Question: Provide a one-line summary of what is displayed.
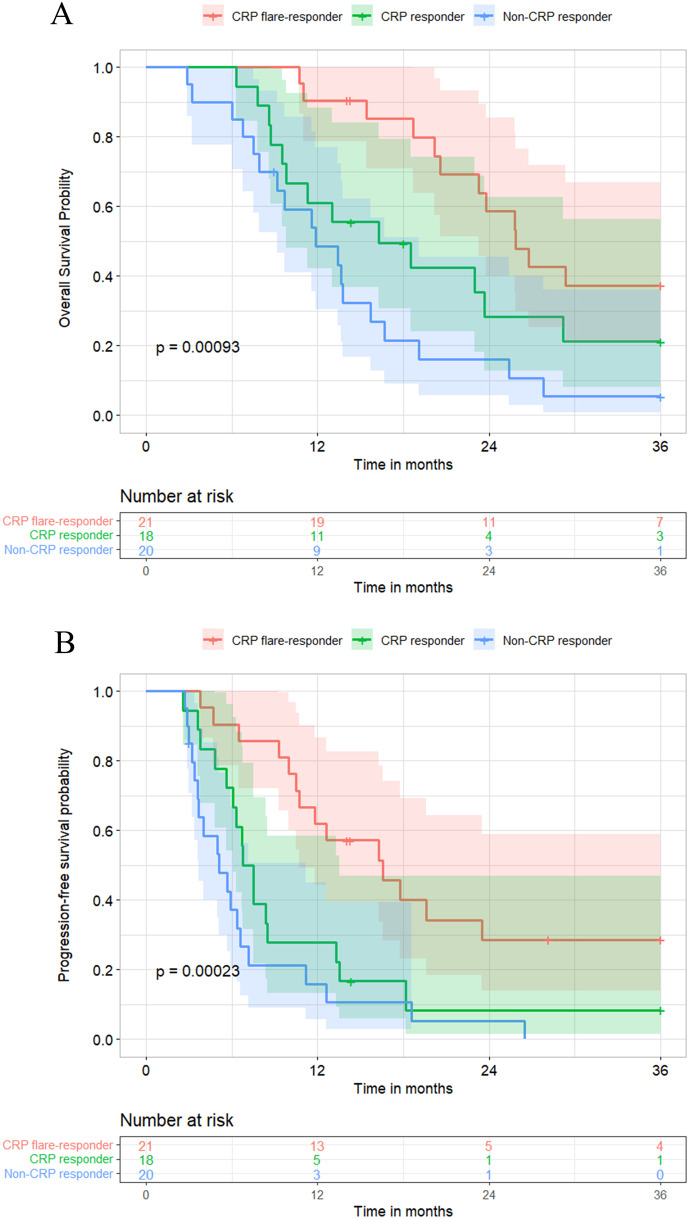
Answer: (A) overall survival curves and (B) progression-free survival curves based on early CRP kinetics.